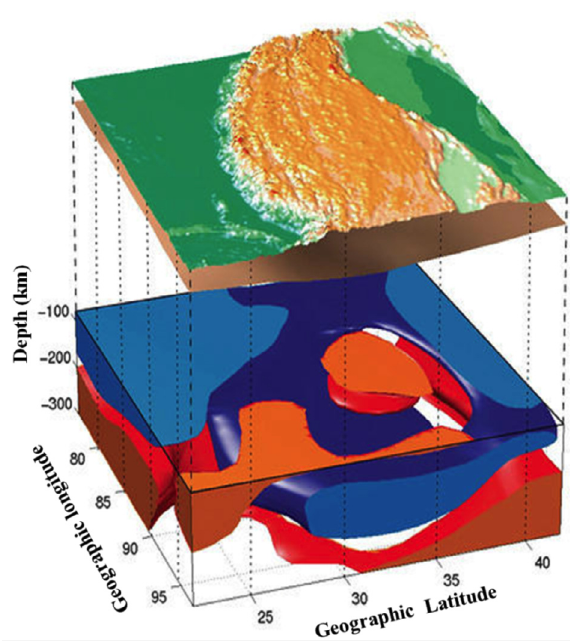
Figure 1. Structure and deformation of the Tibetan lithosphere.